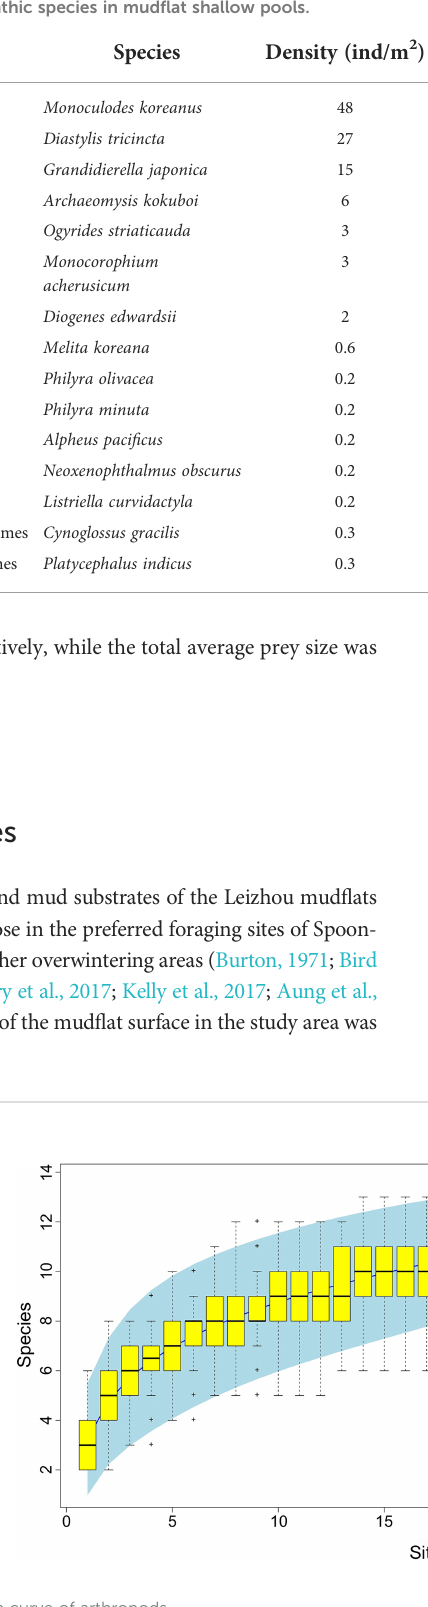
TABLE 4 Mobile epibenthic species in mud fl at shallow